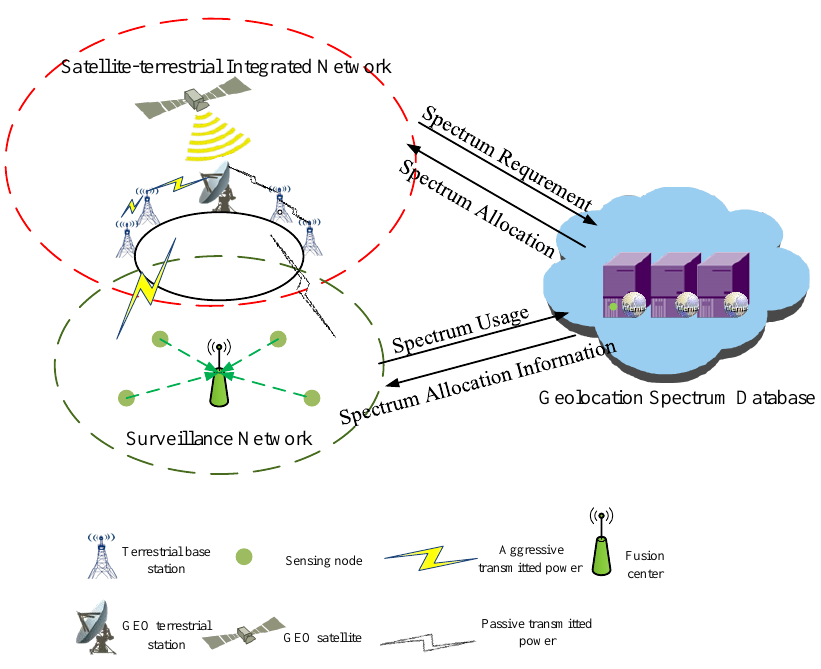
Figure 1. The generalized detection model for the transmitted power violation (TPV) in the downlink scenario of satellite-terrestrial spectrum sharing, which consisted of satellite-terrestrial integrated network, geolocation spectrum database, and surveillance